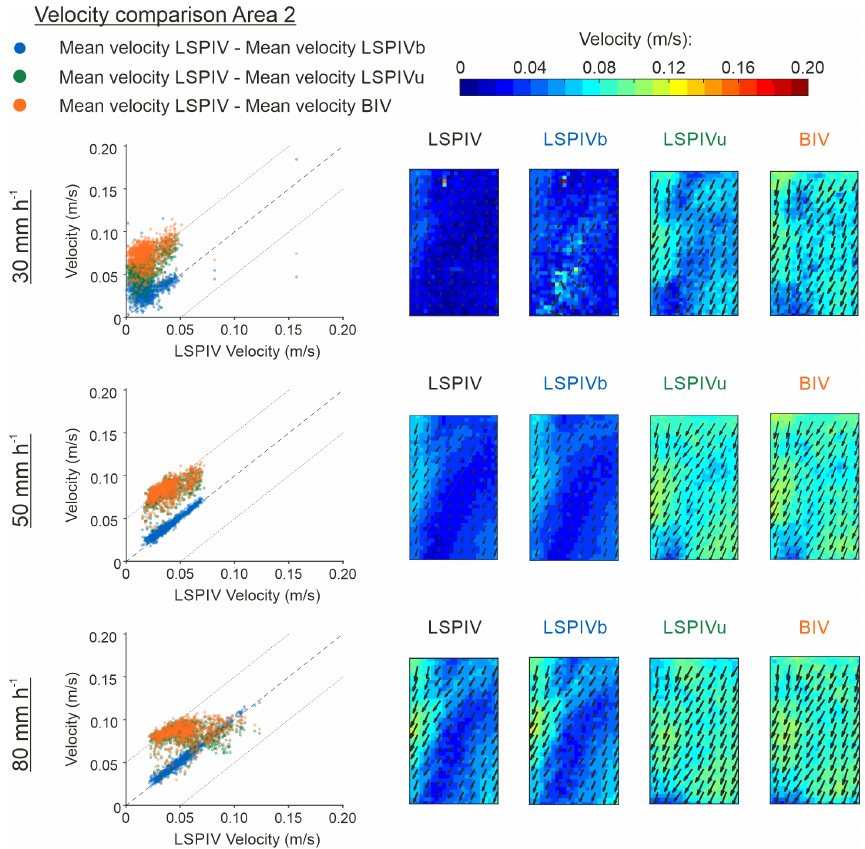
Figure 7. Velocity comparison between imaging velocimetry techniques results (LSPIV, LSPIVb, LSPIVu, and BIV) in Area 2 for the three different rain intensities (30, 50, and 80mmh − 1 ) . The velocity fields obtained for each case are also plotted for a qualitative